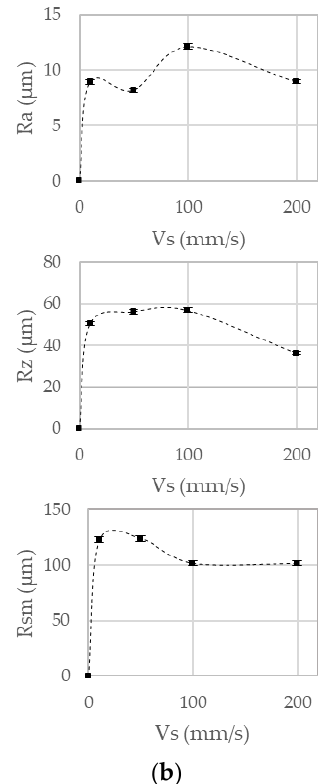
Figure 2. Profile Roughness parameters: ( a ) At different Ed at Vs = 10 mm/s; ( b ) At different Vs at Ed = 35.37 J/cm 2 .